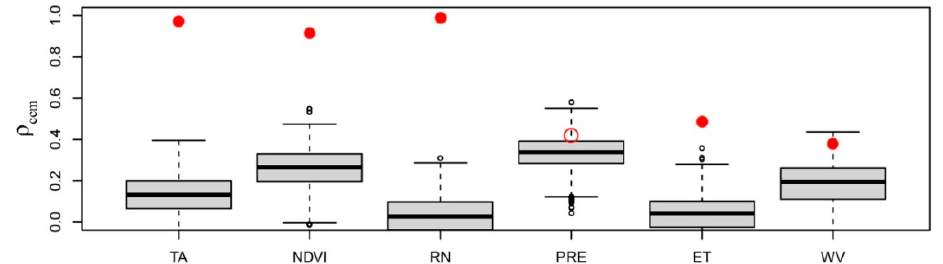
Figure 4. SST detection between LST and environmental factors for the pixel selected from PMC region. The red circles indicate the ρ ccm between LST and environmental factors. The box plot shows the distribution of ρ ccm between LST and the 500 seasonal surrogate series of environmental factor, which has the same seasonal cycle with the environmental factor. The top and bottom of the box are the upper and lower quartiles, the middle thick line is the median, and the vertical portion extending above and below is the range of the data, with the furthest point being 1.5 times quartile. Beyond that is the outlier, indicated by a gray circle.